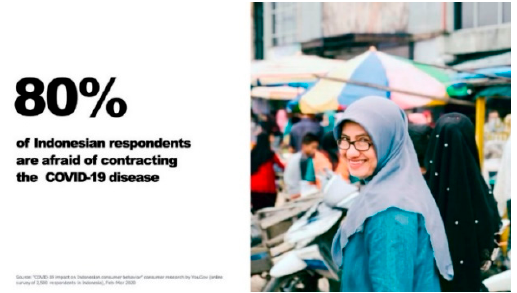
Figure 1. Coronavirus impact (Survey by Facebook).